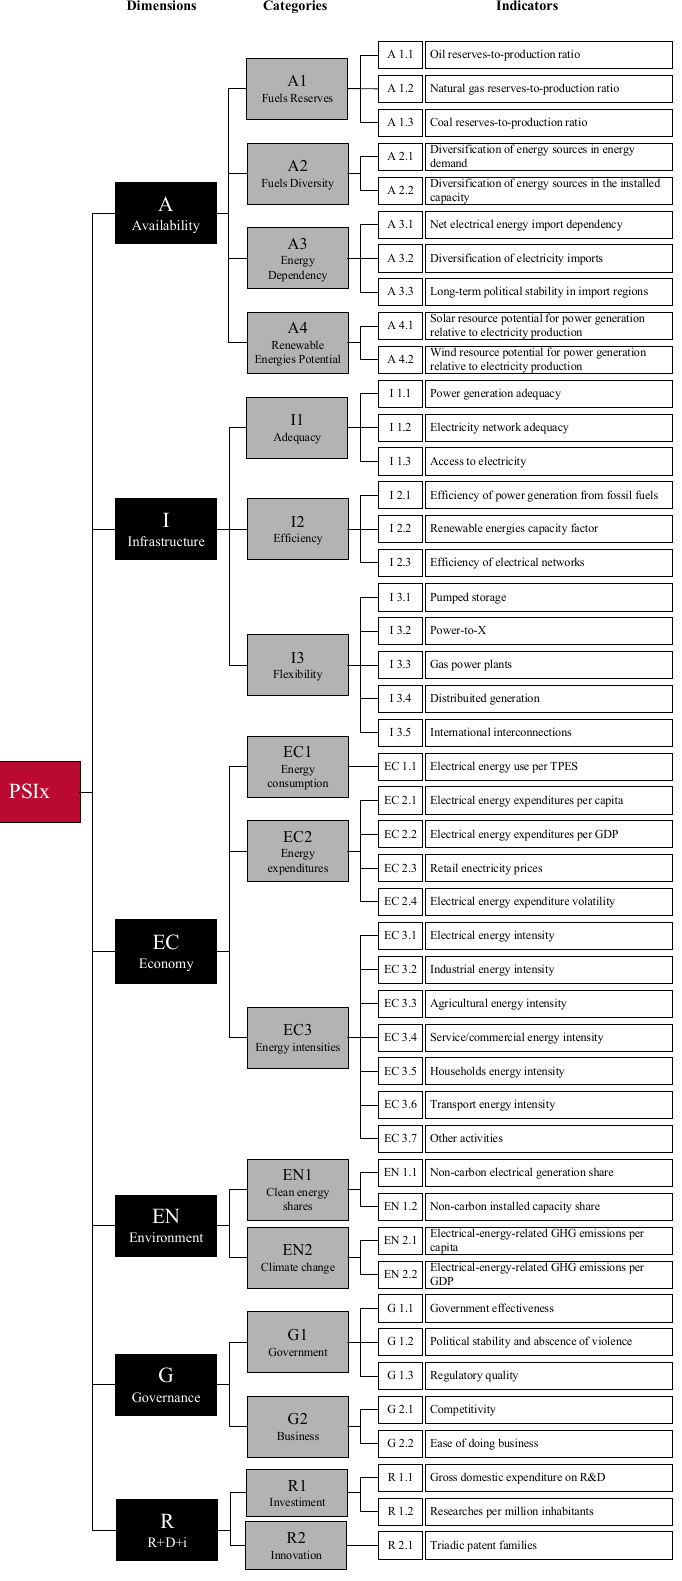
Figure 1. Power System Security Index (PSIx) structure.